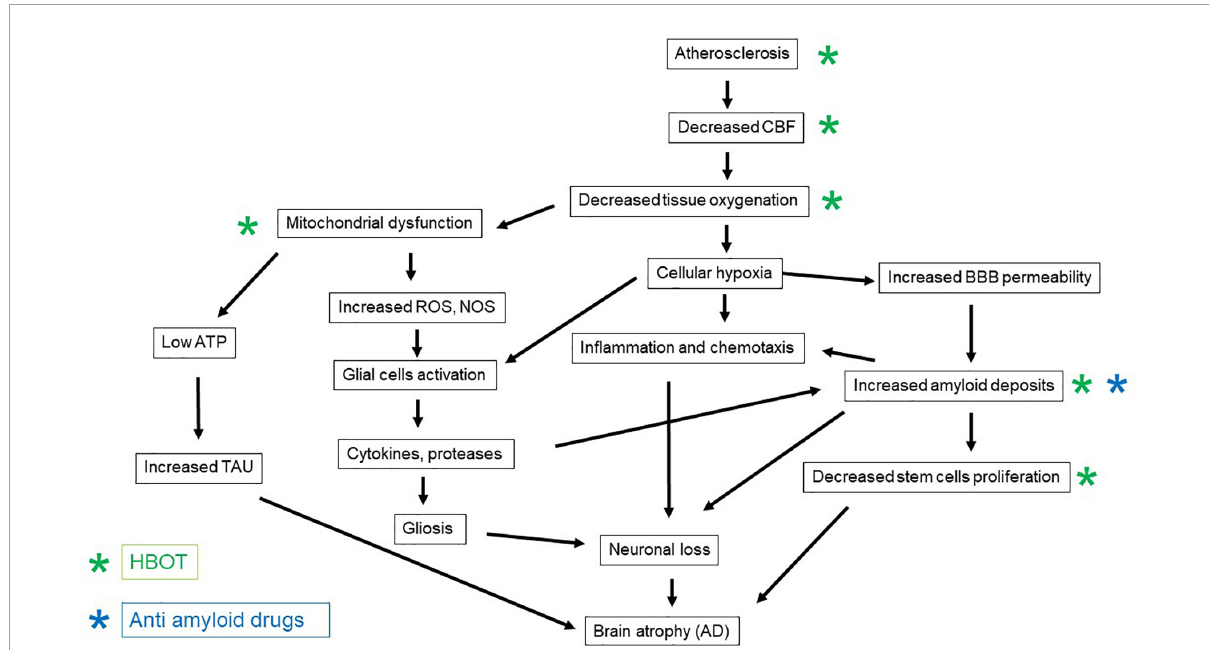
FIGURE1 The patho-mechanisms induced by brain ischemia and the development of Alzheimer’s disease, and the counteractive effects of anti-amyloid medications and